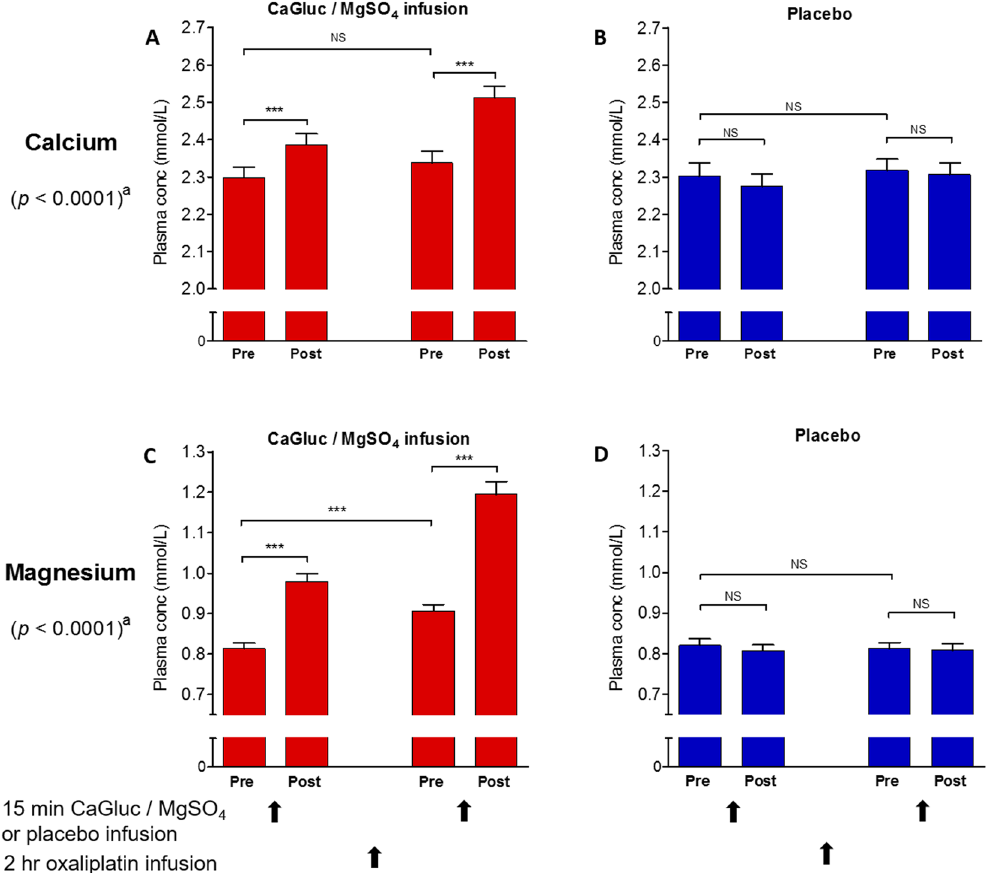
Figure 3. Plasma calcium ( A , B ) and magnesium ( C , D ) concentrations in colorectal cancer patients measured before and after CaGluc/MgSO 4 (red) or placebo (blue) infusions given with oxaliplatin chemotherapy. “Pre” and “post”refer to the timing of the plasma calcium and magnesium measurements before or after the CaGluc/ MgSO 4 infusions. The p values shown as p < 0.0001 are for a comparison of measurements determined with CaGluc/MgSO 4 versus placebo infusions using repeated measures one way ANOVA, and those shown as *** ( p < 0.001) or NS (not significant) are from Tukey’s multiple comparison test. Plasma calcium and magnesium concentrations were increased after CaGluc/MgSO 4 infusions but not after placebo infusions. CaGluc/MgSO 4 : calcium gluconate/magnesium sulfate